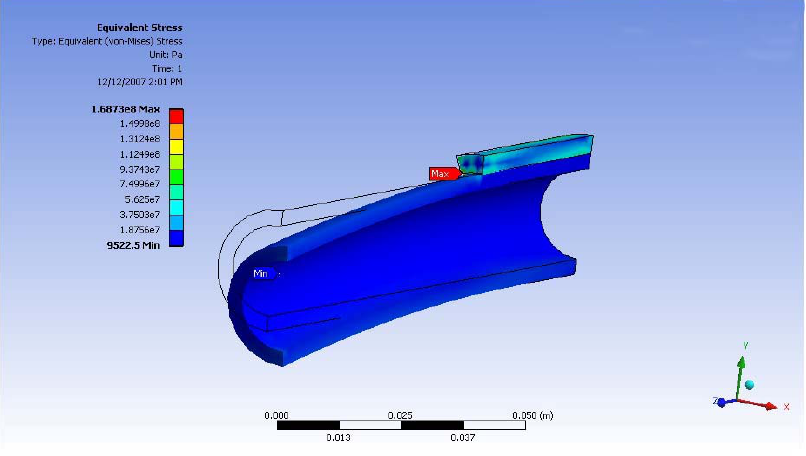
Fig.6 Pure bending loading of the plated-bone model